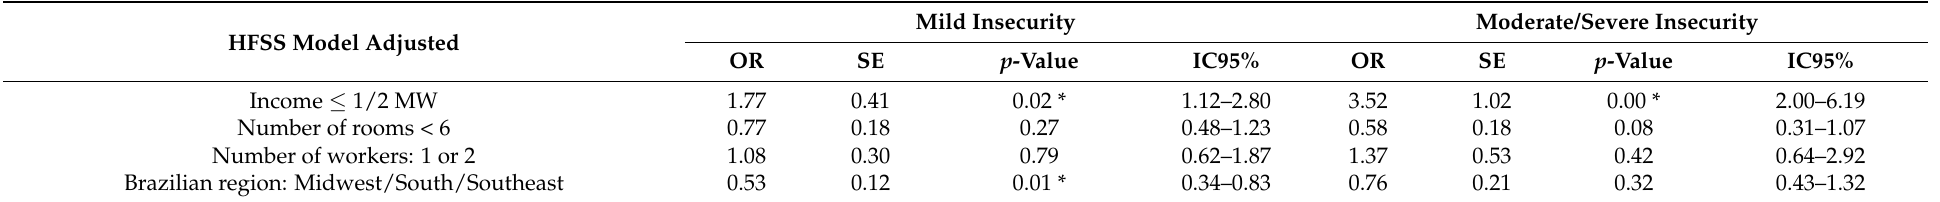
Table 5. An adjusted multivariate model of the Household Food Security Situation (HFSS) (reference group: food security) determinants among food handlers in Brazilian community